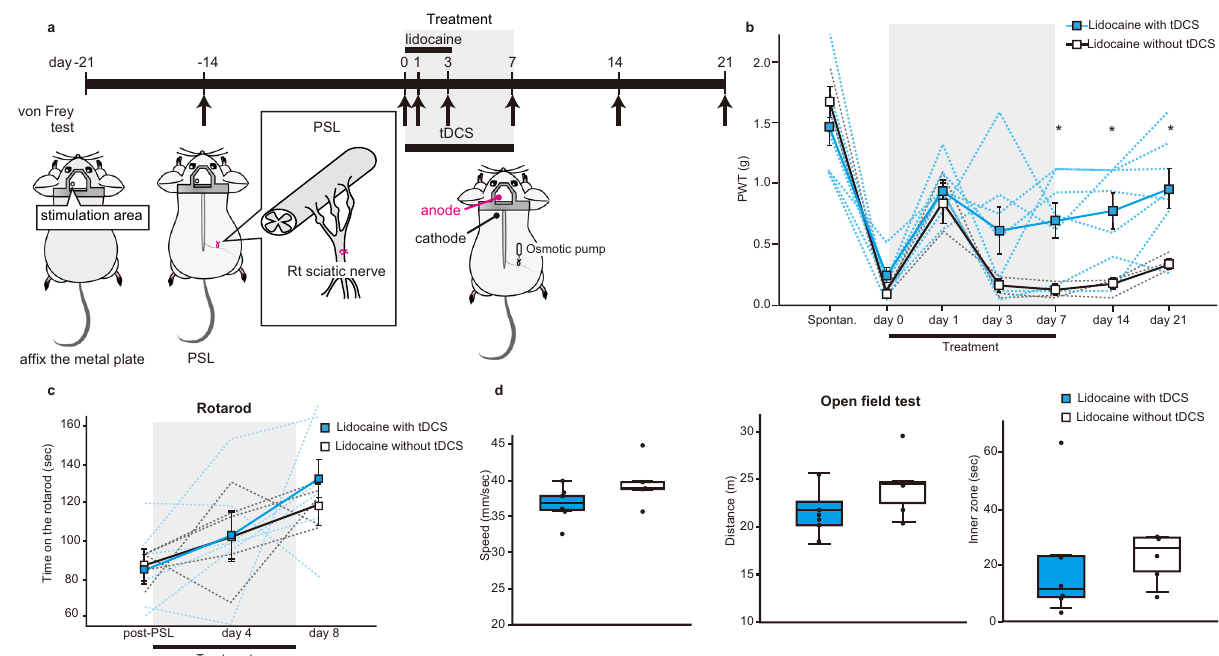
Fig. 5 tDCS-lidocaine therapy reverses mechanical allodynia-like behaviour without affecting rotarod and open fi eld behaviours. a Schematic of the experimental schedule. The start of tDCS-lidocaine (or control) treatment was designated as “ day 0 ” . Lidocaine was continuously administered (upper black bar) to the injured right sciatic via elution from a subcutaneously implanted osmotic pump from day 0 to day 3 (when the pump was removed). Surgery for head-plate fi xation and PSL, and measurement of mechanical paw withdrawal thresholds (arrows), and tDCS administration (lower black bar, day 0 to day 7) were performed as in Fig. 1. b Graph plotting mechanical paw withdrawal thresholds as mean ± SEM at various time-points before PSL (Spontan.), and before (day 0), during (day 1 – day 7) and after (day 8 onwards) the treatment period (grey shading) for lidocaine with tDCS (blue, n = 7 mice) or control lidocaine-alone (white, n = 3 mice). Dashed-lines represent individual mice. Statistical signi fi cance was tested using a two-way repeated measures ANOVA, followed by Bonferroni post-hoc tests comparing treatment cohorts at each time-point, * p < 0.05. Source data are provided as a Source Data fi le. c Graph plotting the latency to falling during the accelerating rotarod assay at various time-points before (post-PSL), during (day 4) and after (day 8) the treatment period (grey shading) for lidocaine with tDCS (blue, n = 6 mice) or control lidocaine-alone (white, n = 5 mice). Dashed-lines represent individual mice. Statistical signi fi cance between treatment cohorts was tested using a two-way repeated measures ANOVA. Source data are provided as a Source Data fi le. d Box and whisker plots of locomotor activity (Left: speed, Centre: distance) and anxiety behaviour (Right: time spent in inner zone) following the treatment period for lidocaine with tDCS (blue, n = 6 mice) or control lidocaine-alone (white, n = 5 mice). Population medians, fi rst and third quartiles are represented by the boxes, maxima and minima by the whiskers, and individual mice by the overlaid single points, respectively.